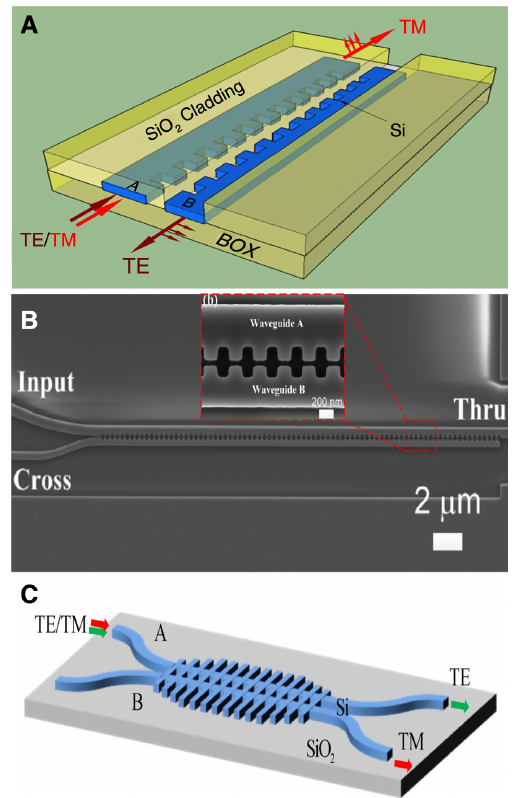
Figure 3: Schematic diagrams of the subwavelength structured PBSs.